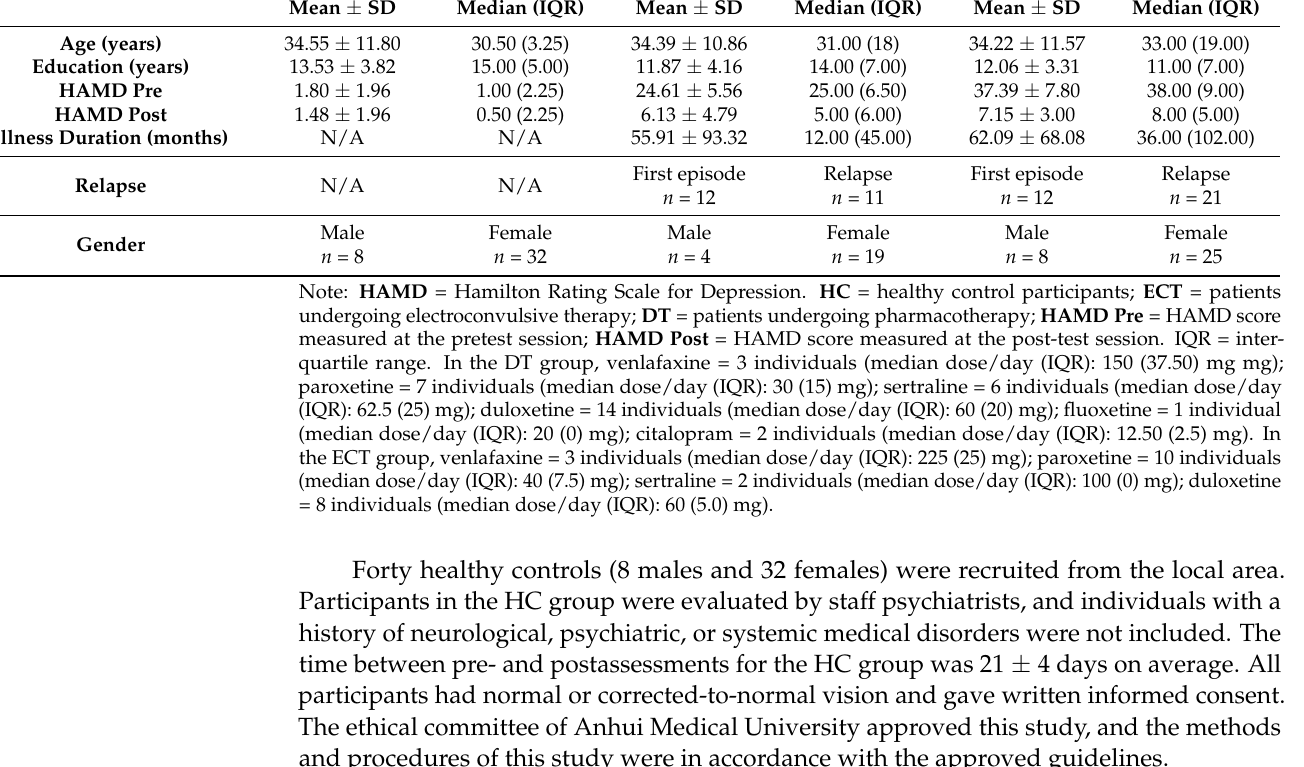
Table 1. Separate demographic and clinical characteristics for each group. Measures of central tendency (median and mean) and of dispersion (IQR and SD) are reported for each variable. HC ECT